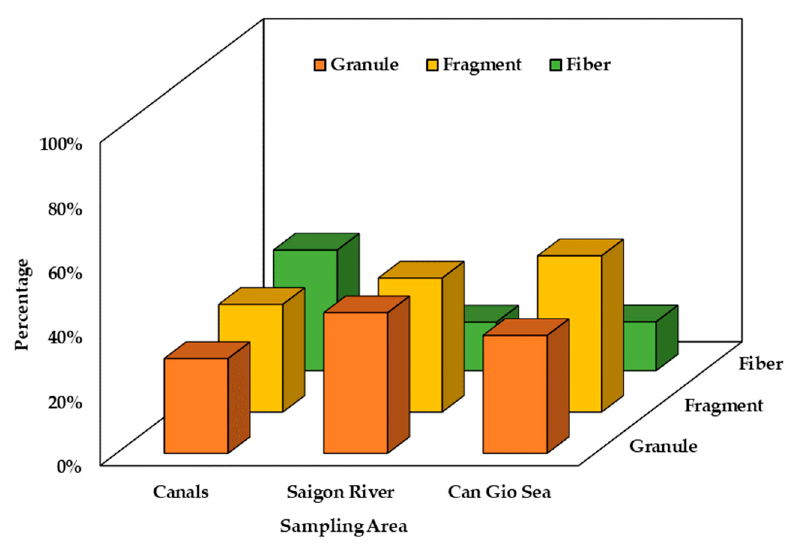
Figure 6. Shape distribution of MPs in canal systems, Saigon River, and Can Gio Sea, in August 2020.